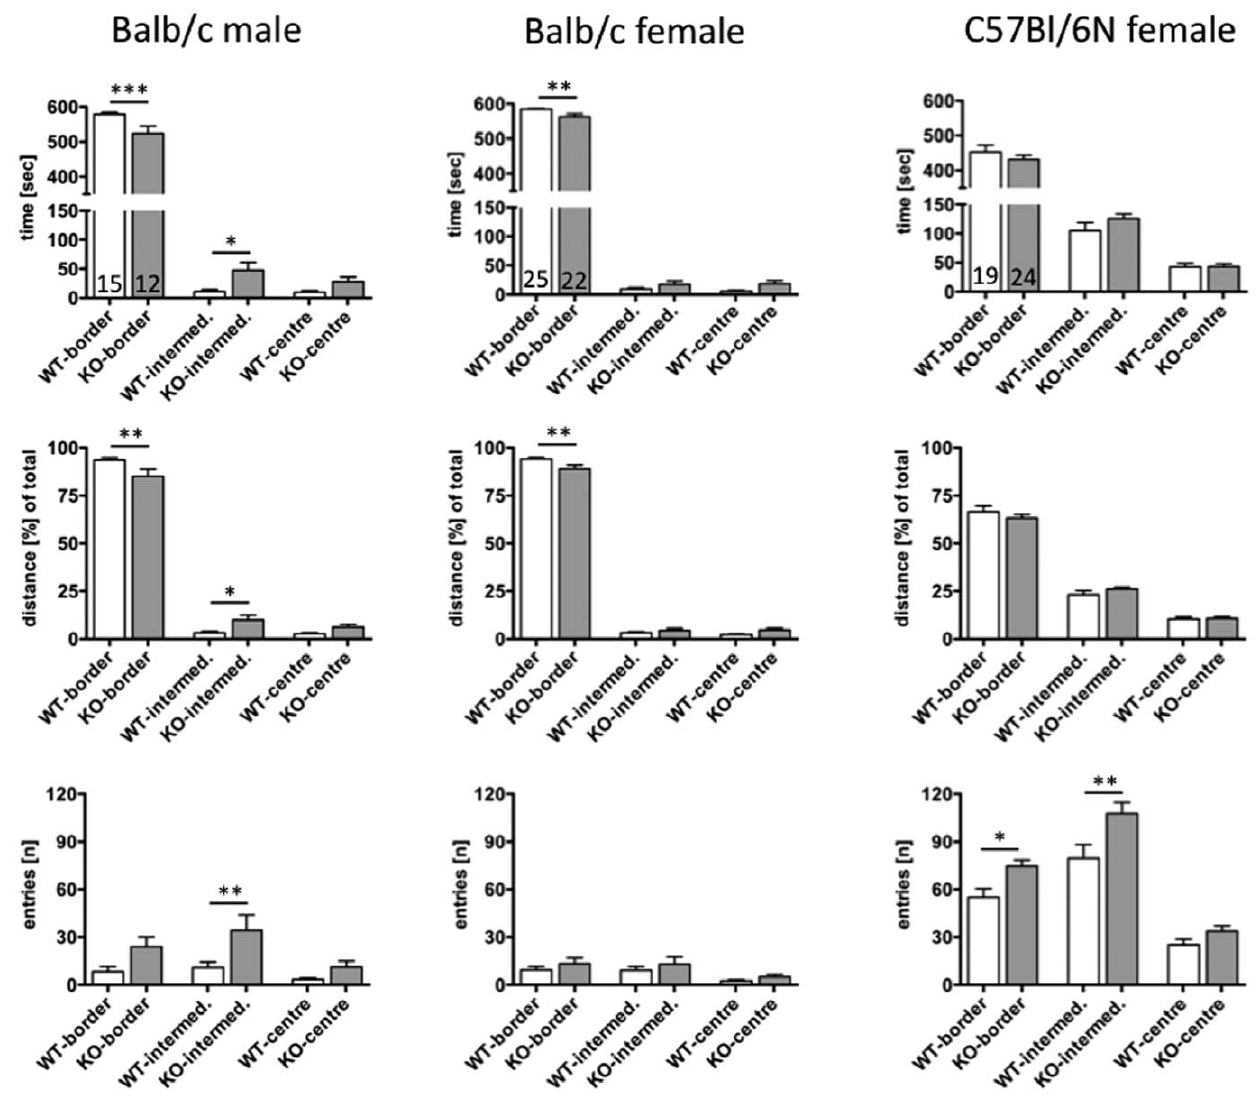
Figure 1. Ambulation in the open field by Pdyn KO (shaded bars) and WT (white bars) mice was measured for 10 min. Time spent (upper row), distance travelled (mid row) and number of entries (lower row) into the different zones are given for male (left column) and female (mid column) balb/c and female C57Bl/6N (right column) mice. Data represent mean 6 SD of the number of animals indicated in the bars. Statistical analysis was performed by one-way ANOVA with Bonferroni’s multiple comparison test for comparison of the two genotypes in the different zones of the open-field test. * … p , 0.05; ** … p , 0.01; *** … p , 0.001.